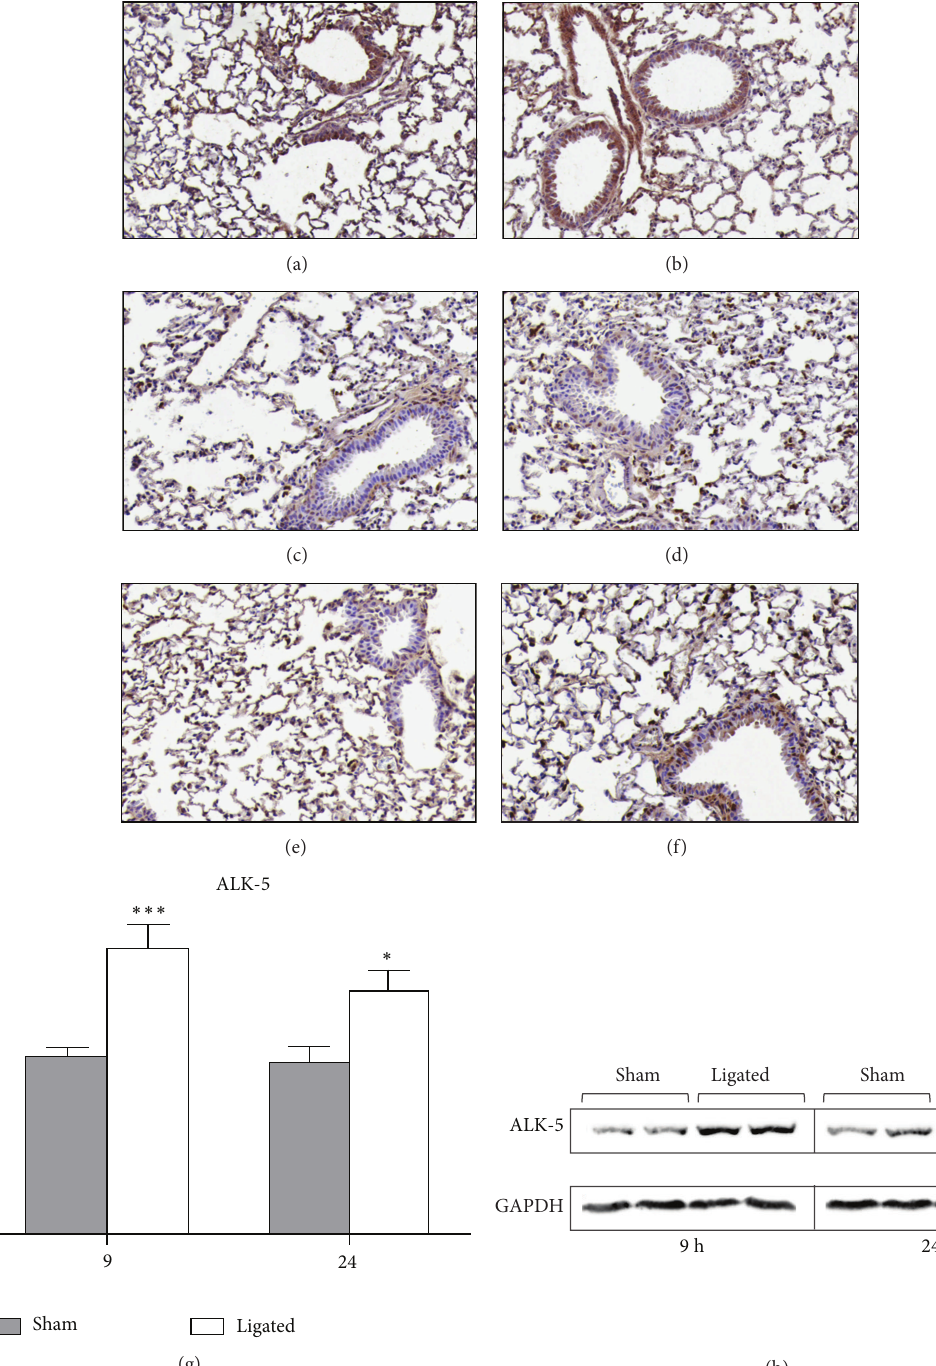
Figure 2: Expression level of the TGF- 𝛽 receptors. Representative images of the levels of T 𝛽 RII at 9h (a and b) and ALK5/T 𝛽 RI at 9h (c and d) and 24h (e-f), and in lung tissue from sham controls (a, c, and e) and after acute pancreatitis induction (b, d, and f). Results from one representativeofeightsamplespergroupareshown.Originalmagnification, × 20.NumberofALK5-positivecellsinthelungsofshamcontrols and ligated groups at 9 and 24h (g). Graph represents number of positive cells as mean ± SEM in 10 microscope fields ( × 20 magnification), 𝑛 = 8 per group. ∗ 𝑃 < 0.05 ; ∗∗∗ 𝑃 < 0.001 versus sham control, two-tailed Student’s t -test. Western blot analysis of total ALK5 protein levels in lung extracts of sham-operated and ligated animals at the early 9 h and advanced 24 h time points (h). Two of five similar analyses per group are